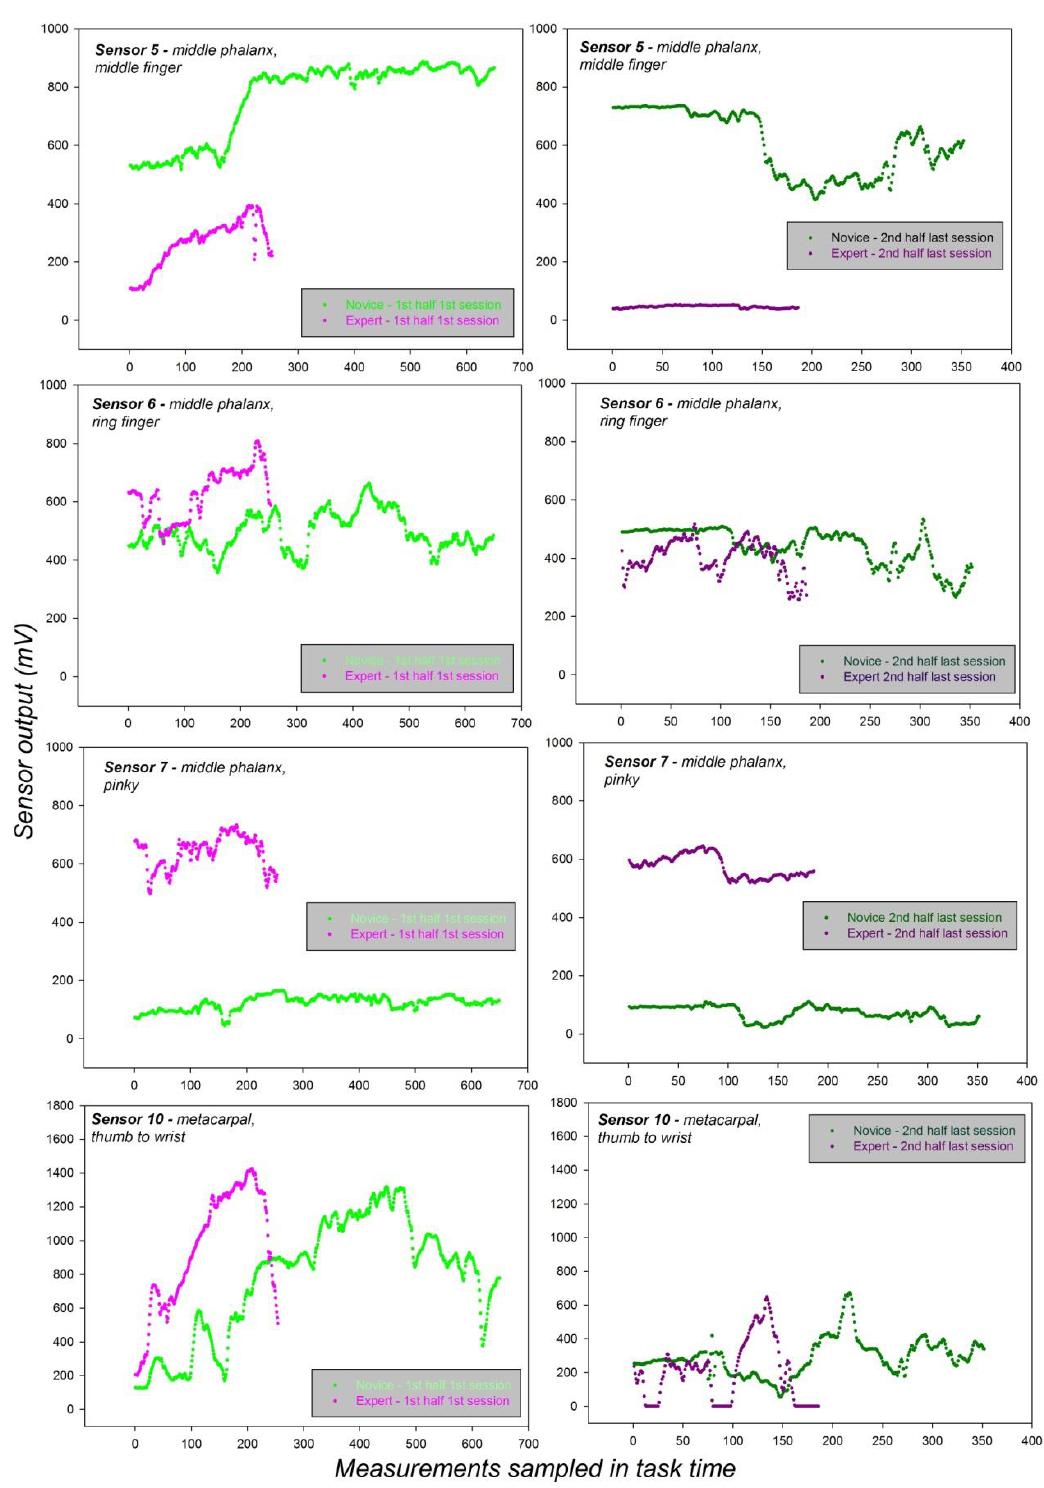
Figure 10. Grip force profiles for each of the four specific sensor locations from the first half of the first task sessions, and from the last half of the last task sessions of the expert and the novice performing the task on the robotic system with their dominant hands.